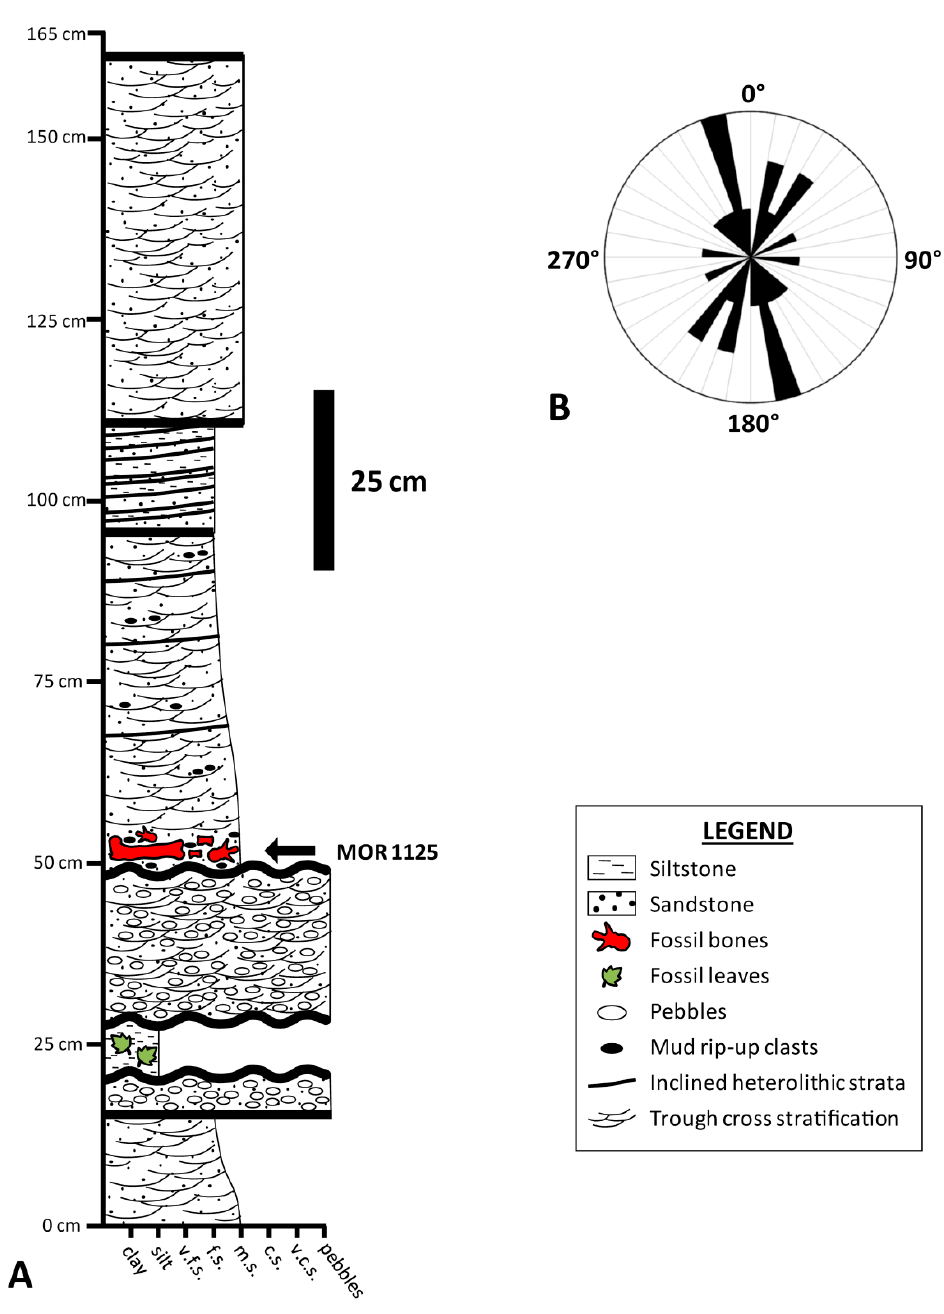
Figure 3. ( A ) Stratigraphic section taken within the MOR 1125 quarry. ( B ) Rose diagram of MOR 1125 bone orientations based on data from 14 long bones collected during the 2002 field season. Presented as an arithmetic plot with 10° bins. Abbreviations: c.s.—coarse sand; f.s.—fine sand; m.s.—medium sand; v.c.s.—very coarse sand; v.f.s.—very fine sand. Scale bar for ( A ) as indicated.